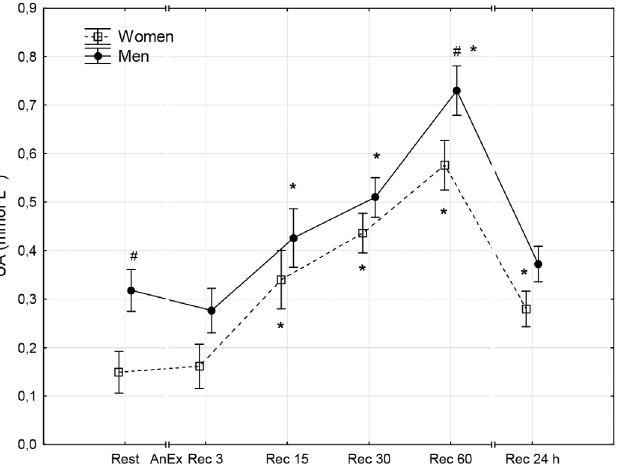
Fig 10. Uric acid concentration (UA) in the serum prior to (Rest) and 3 minutes (Rec 3), 15 minutes (Rec 15), 30 minutes (Rec 30) and 60 minutes (Rec 60) after anaerobic exercise (AnEx). Data are given as mean ± standard error; p < 0.05 statistically significant differences * between results obtained after anaerobic exercise (AnEx) and initial results (Rest); # between results obtained by men and